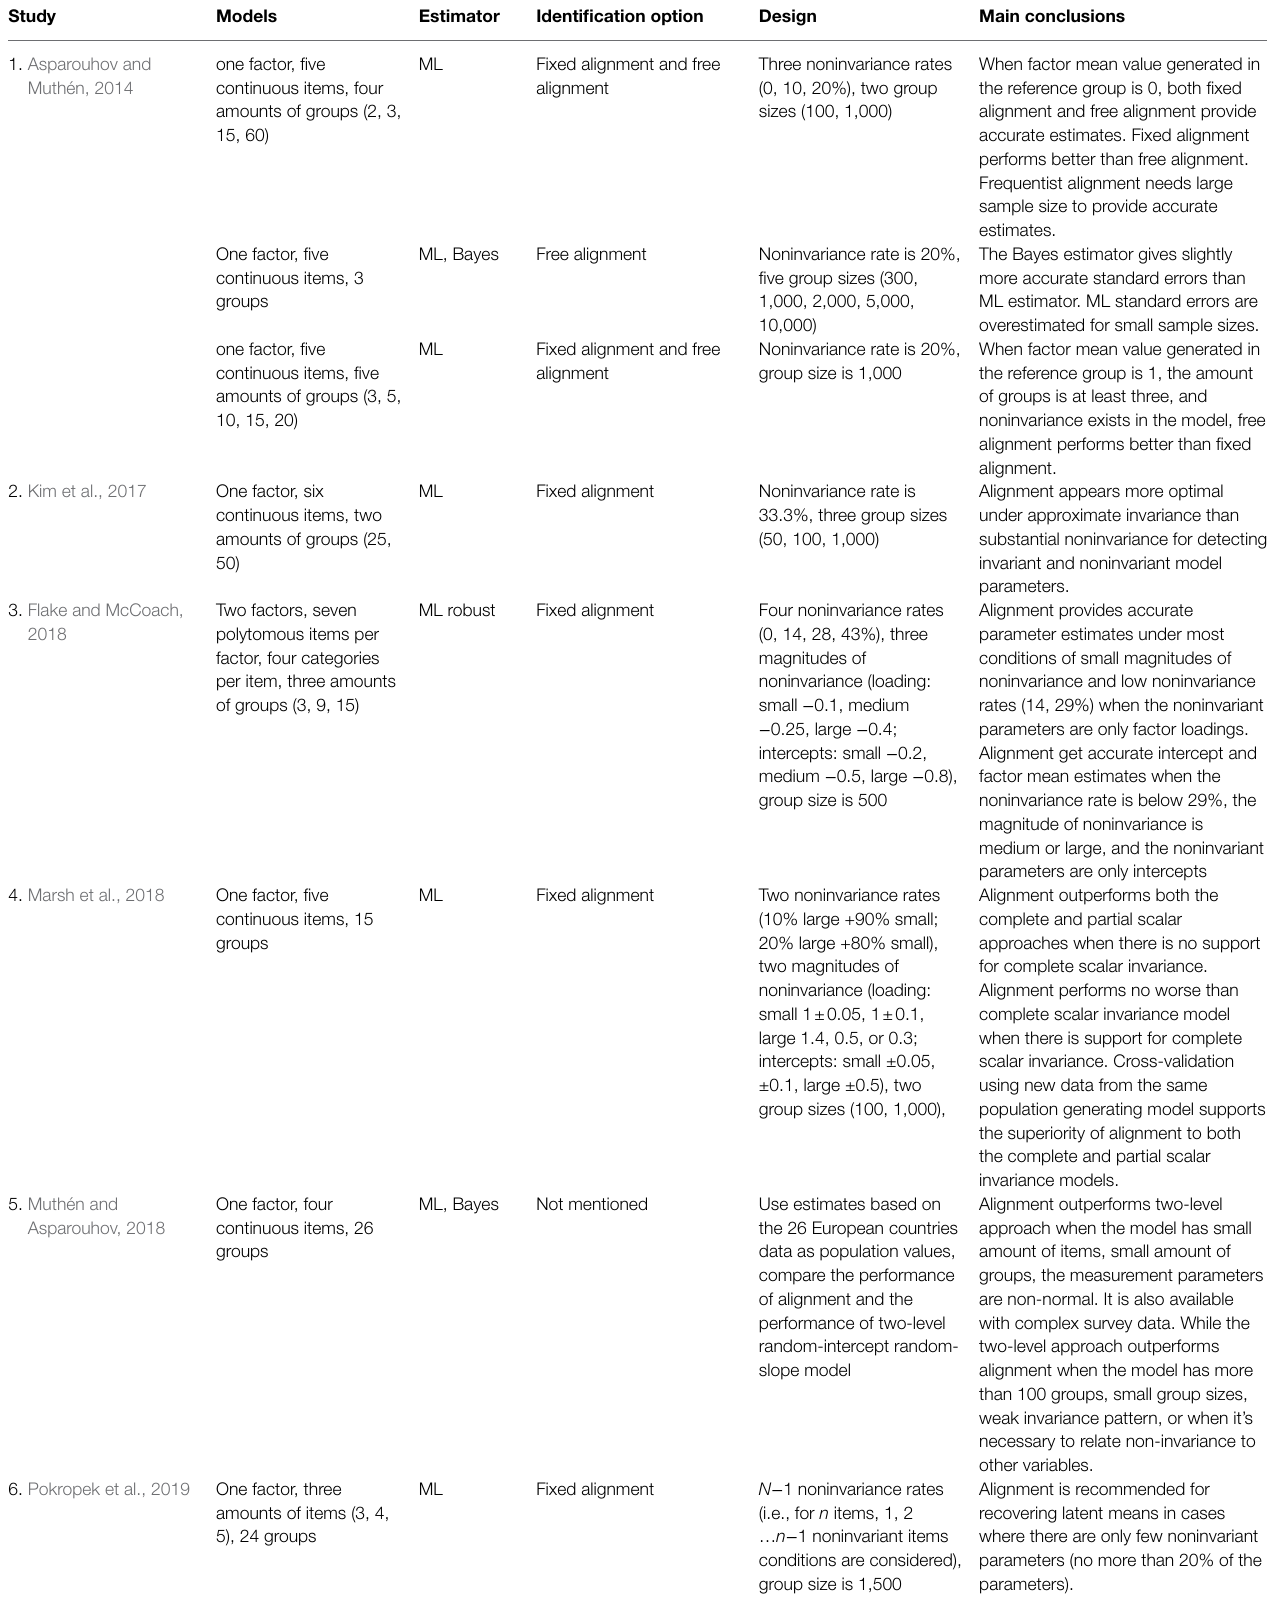
TABLE 1 | Comparison of existing simulation studies about